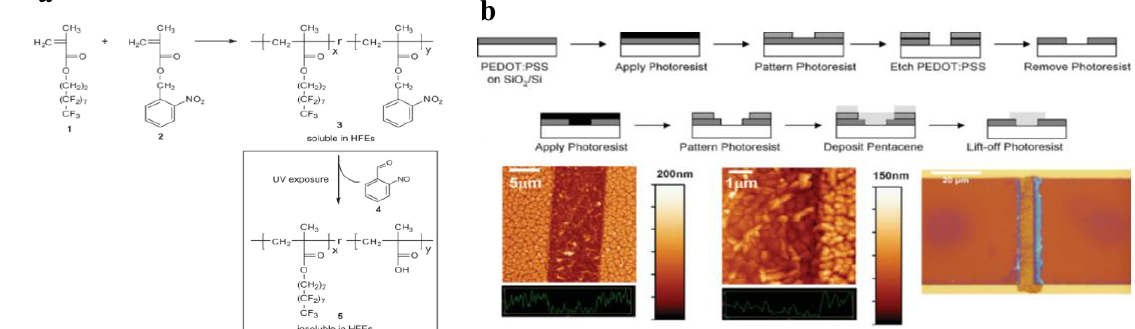
Figure 2. ( a ) Synthesis of the UV-sensitive acid-stable polymer resist 3 and photoinduced deprotection reaction to polymeric carboxylic acid; ( b ) schematic device fabrication of PEDOT: PSS/pentacene bottom-contact OTFT; and optical image of the OTFT (Reprinted with the permission from Reference [78]).